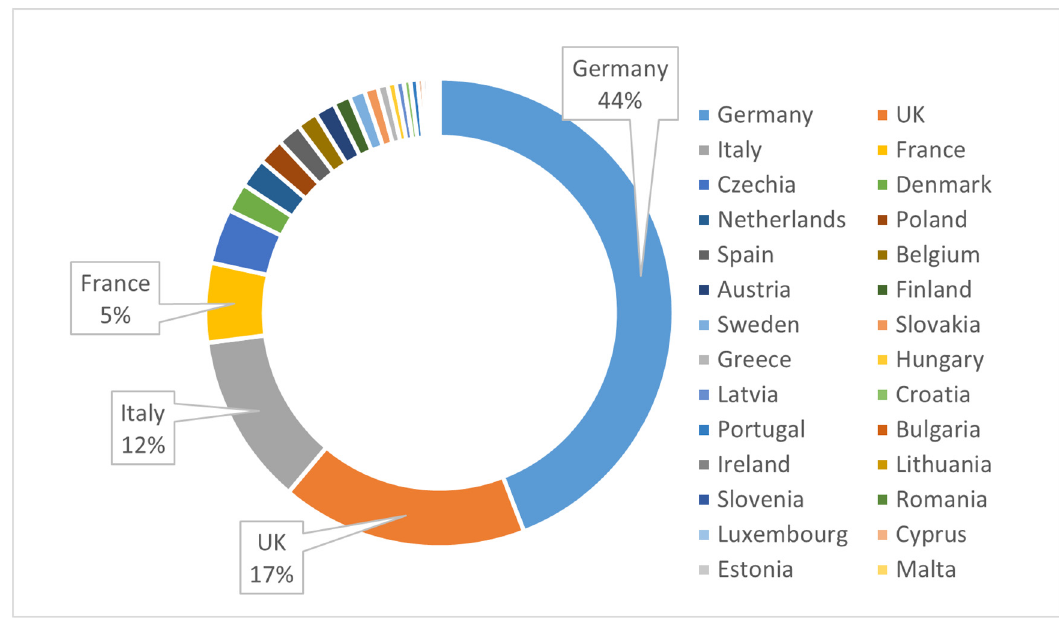
Figure 6. Related shares in biogas production (according to [135]).